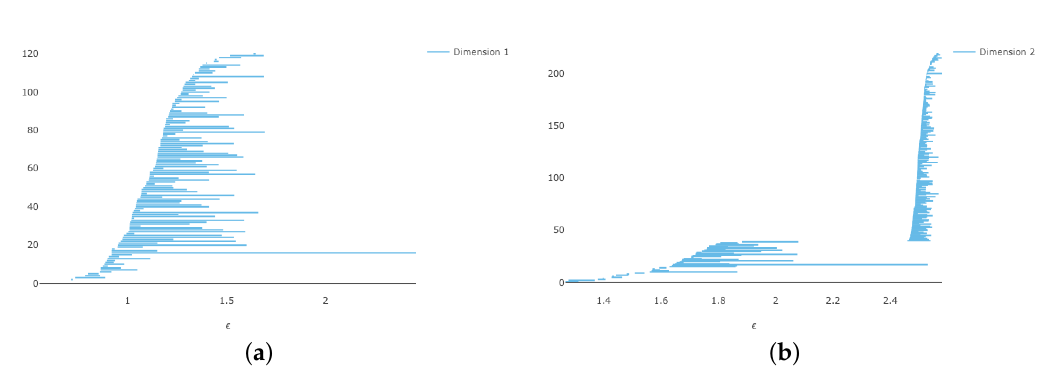
Figure 9. Vietoris–Rips persistence diagrams for 200 points on R P 3 ( a ) H 1 persistence and ( b ) H 2 persistence.